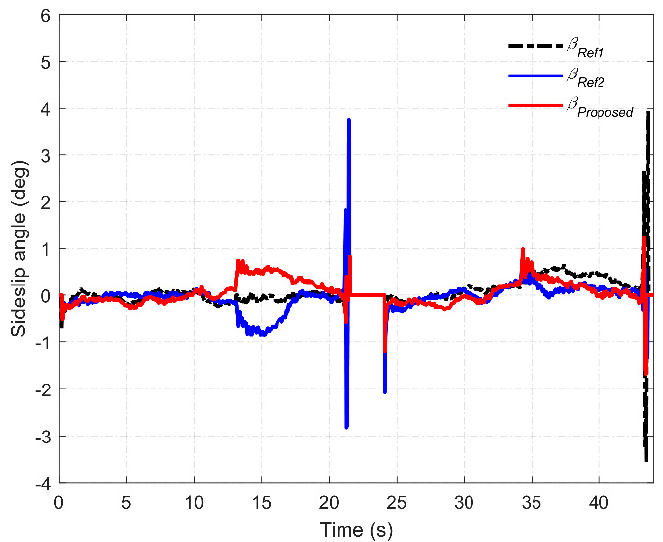
Figure 11. Comparison of sideslip angles.